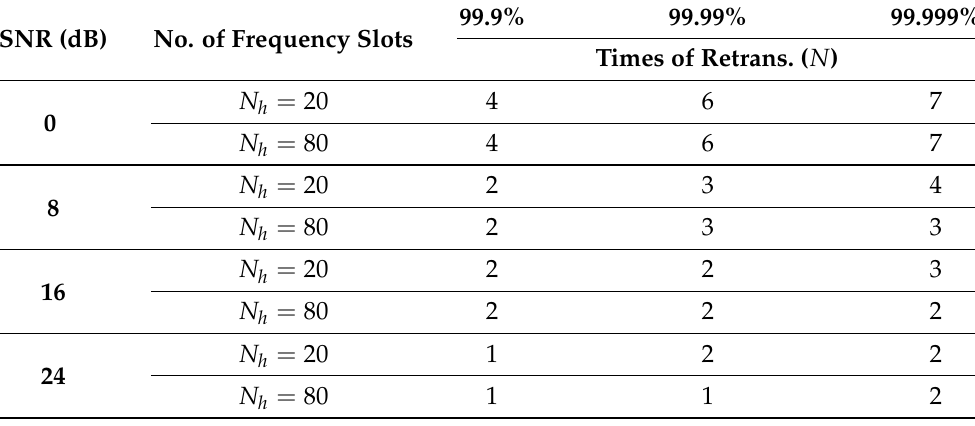
Table 2. The tradeoff between reliability and latency under different system